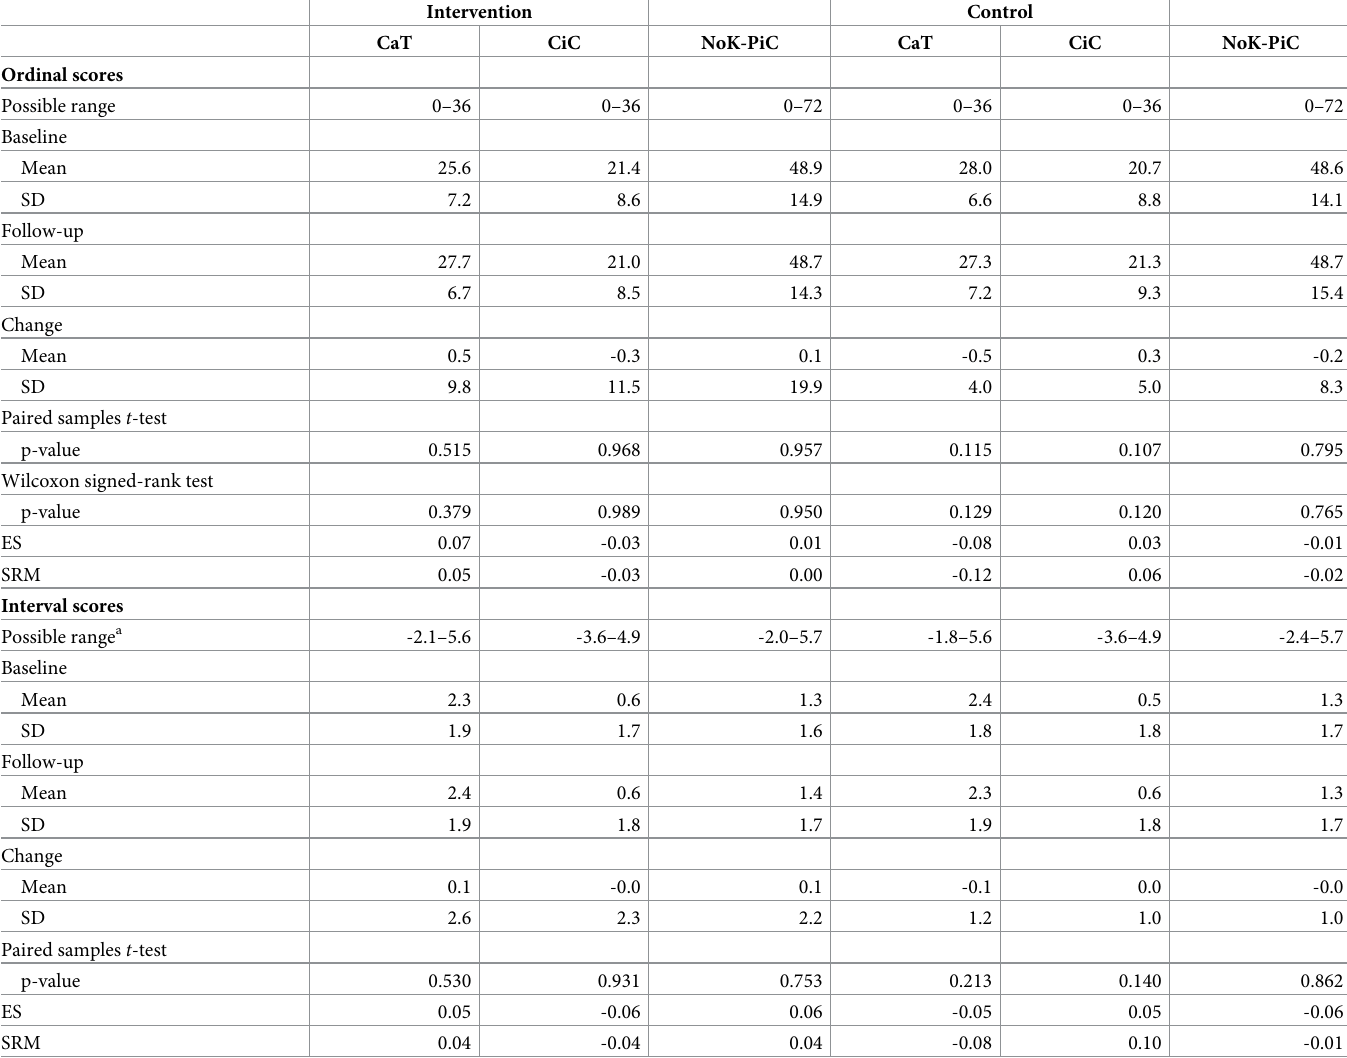
Table 2. Communication and Trust (CaT), Collaboration in Care (CiC) and Next of Kin Participation in Care (NoK-PiC) baseline and follow-up of ordinal and interval scores.